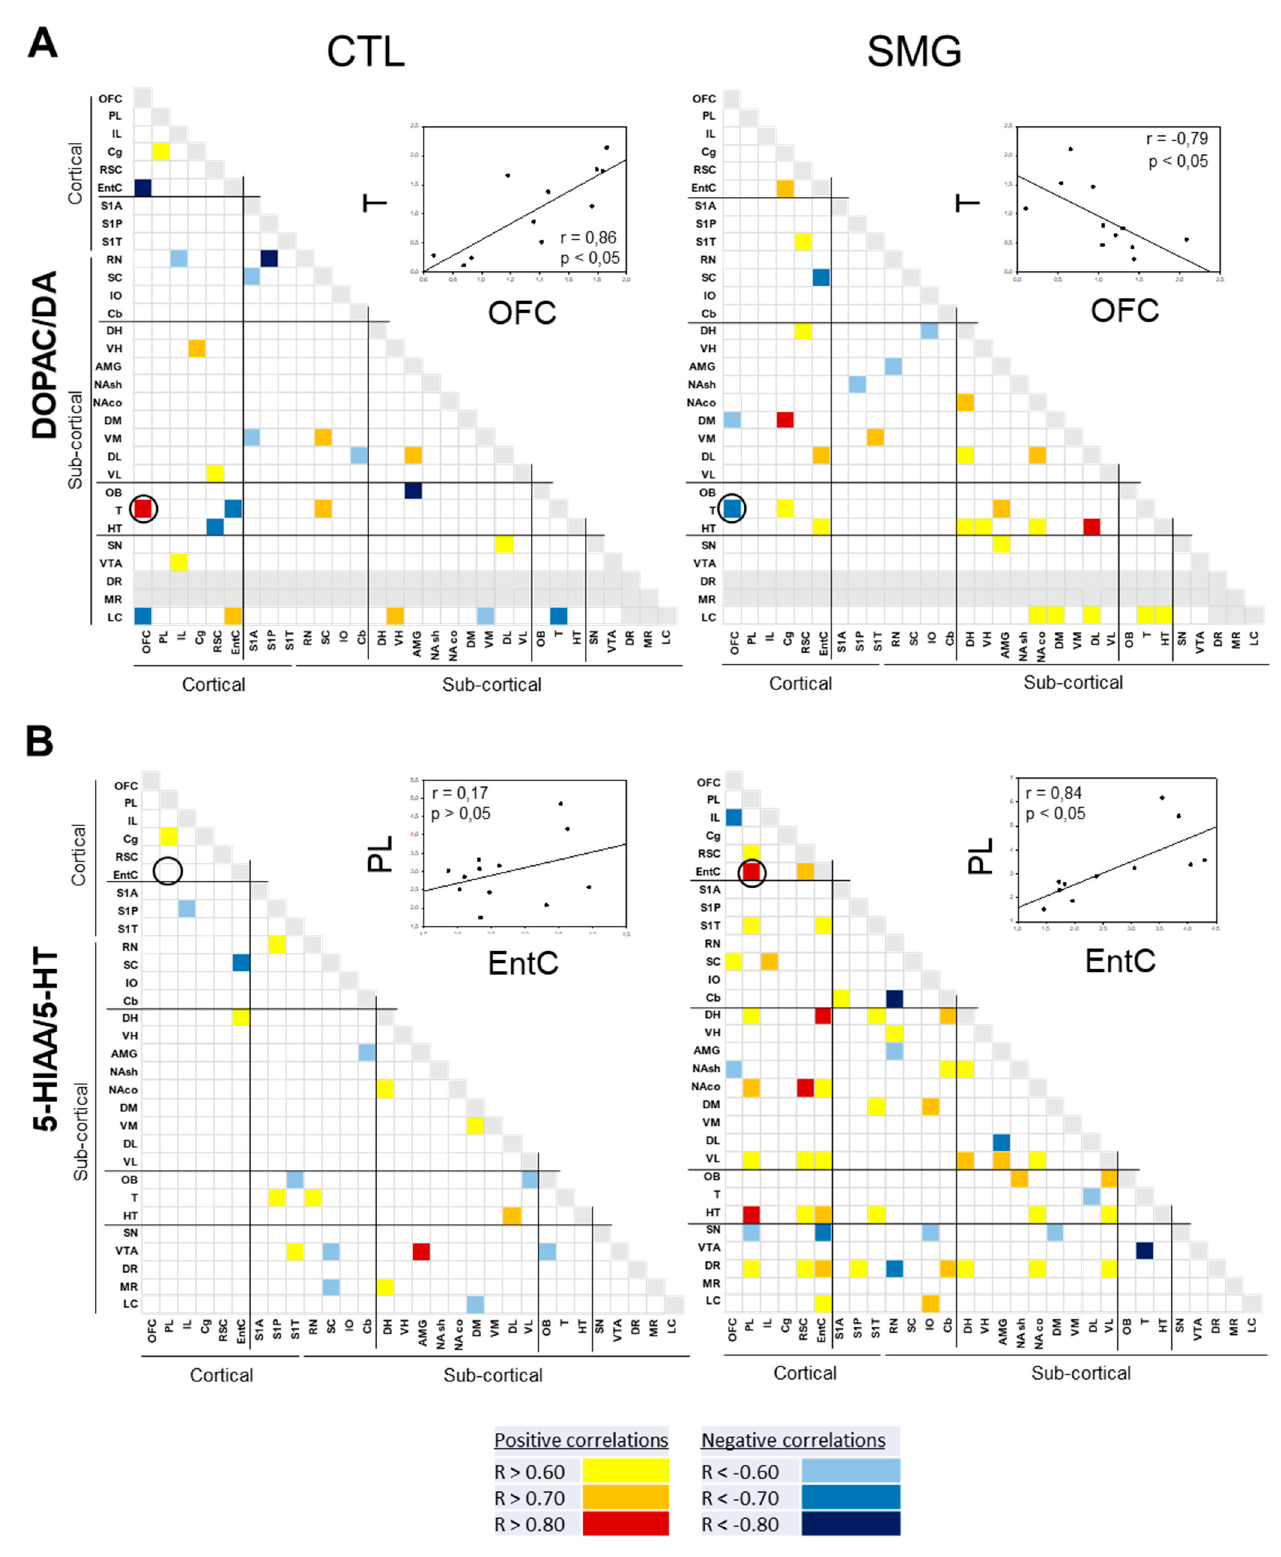
Figure 7. Correlograms for the ratios of DOPAC/DA ( A ) and 5-HIAA/5-HT ( B ) for the CTL and SMG groups. Positive correlations are reported in yellow (r > 0.6) to red (r > 0.8). Negative correlations are reported in light blue (r < − 0.6) to deep blue (r < − 0.8). The insert illustrates a representative correlation between brain regions indicated by the circle. Only significant correlations ( p < 0.05) are